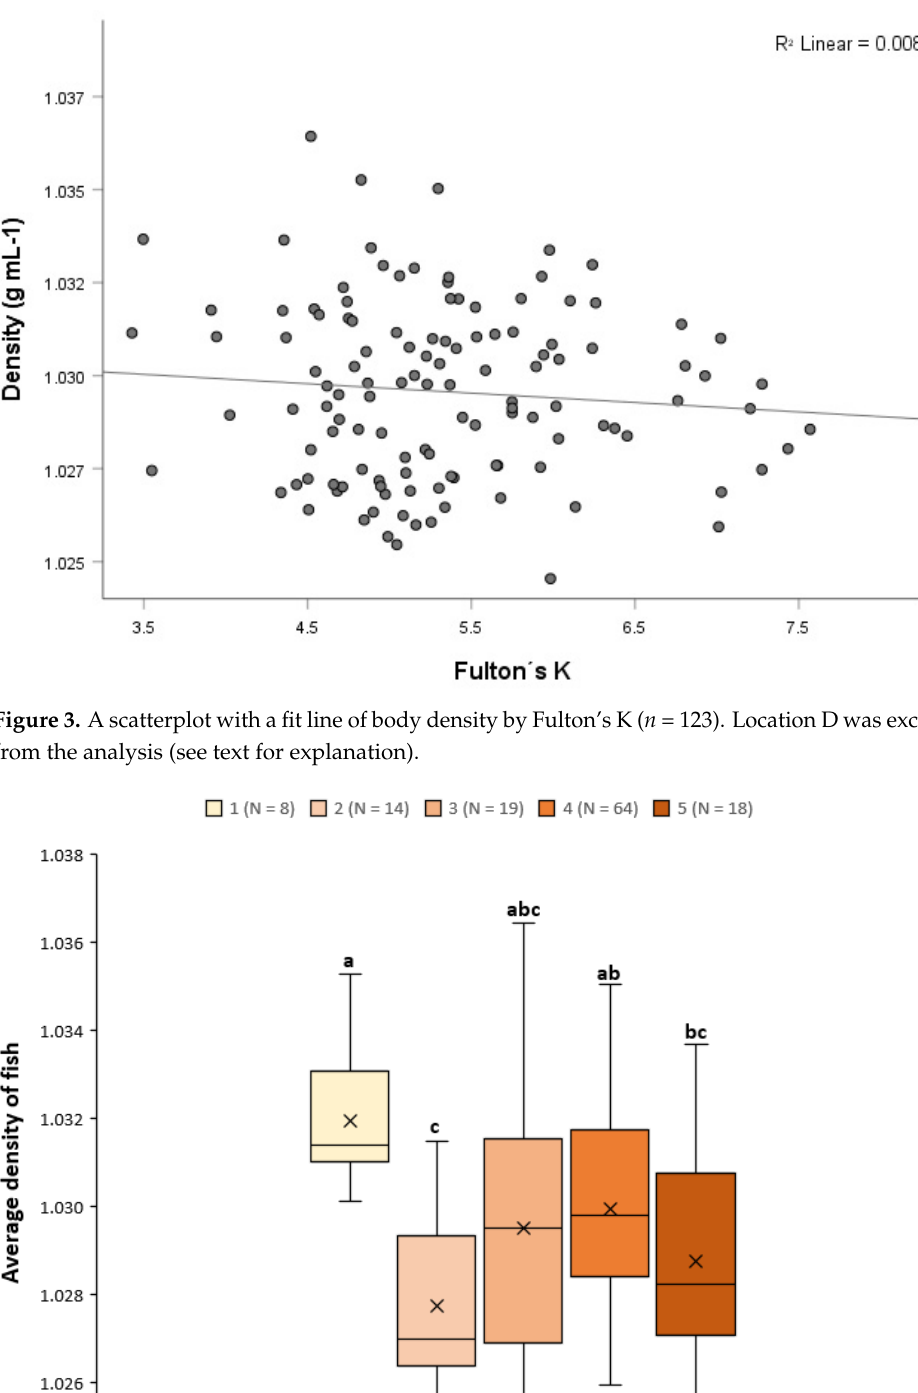
Figure 4. Body density compared to the liver colour of the lumpfish. Different letters indicate significant differences (Tukey’s post-hoc test, p < 0.05) between liver colours. Whiskers indicate minimum and maximum values, while boxes indicate Q1, median, and Q3 quartiles. The × indicates the average body density. Location D is excluded from this